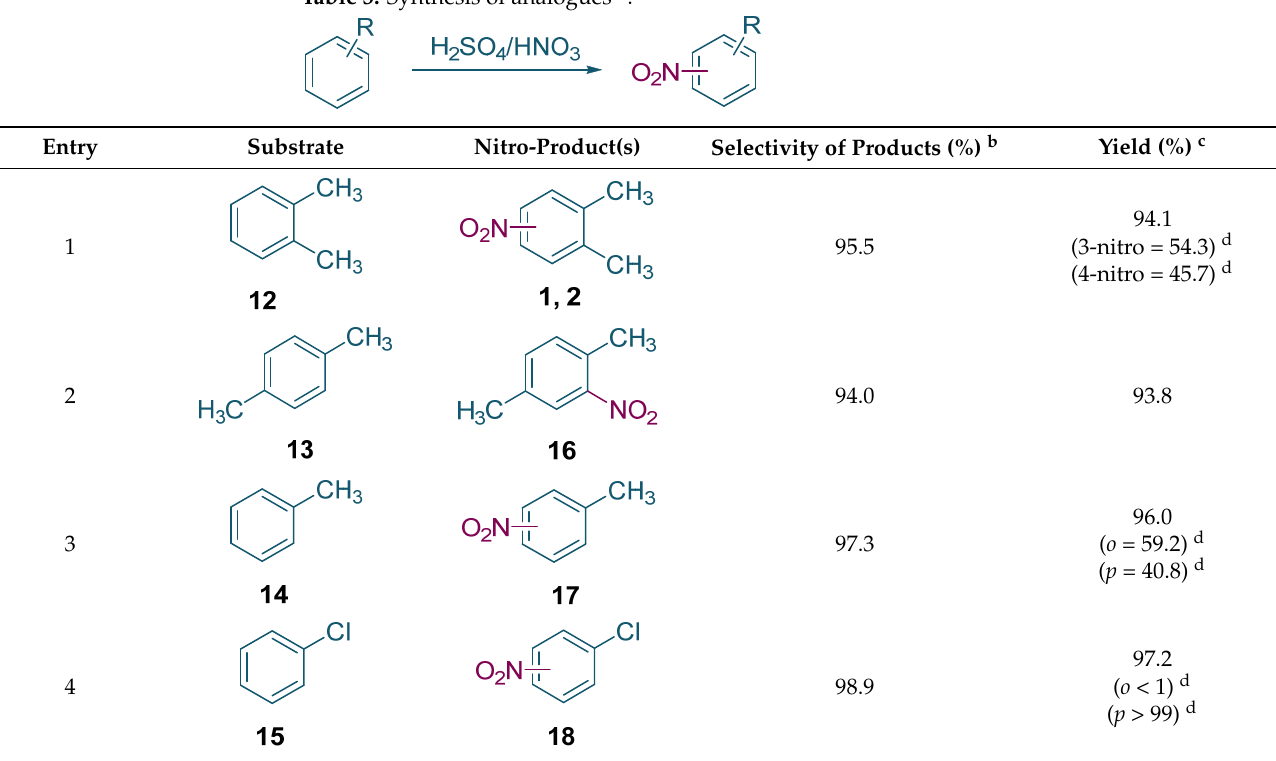
Table 3. Synthesis of analogues a.